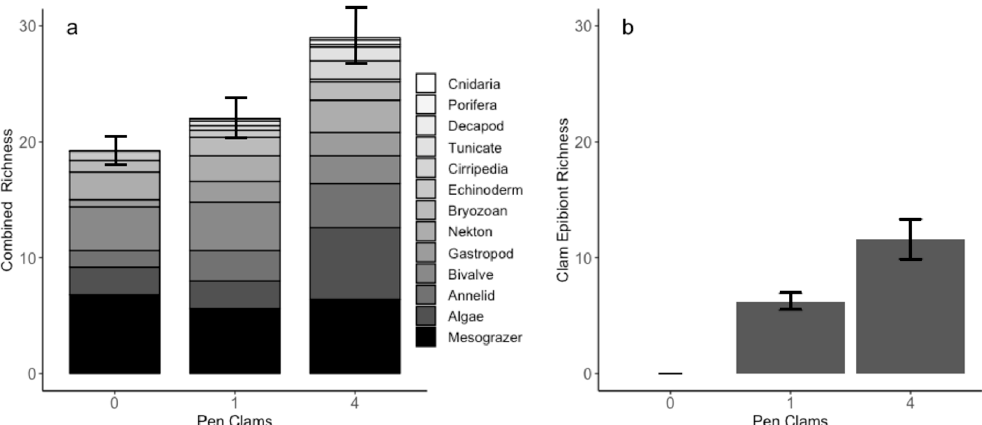
Figure 4. Quantified species richness in plots from combined ( a ) nekton, algal, and shell communities averaged across treatments, gray-toned by taxonomic group, and ( b ) species richness of clam epibiont communities alone. Error bars represent standard errors.